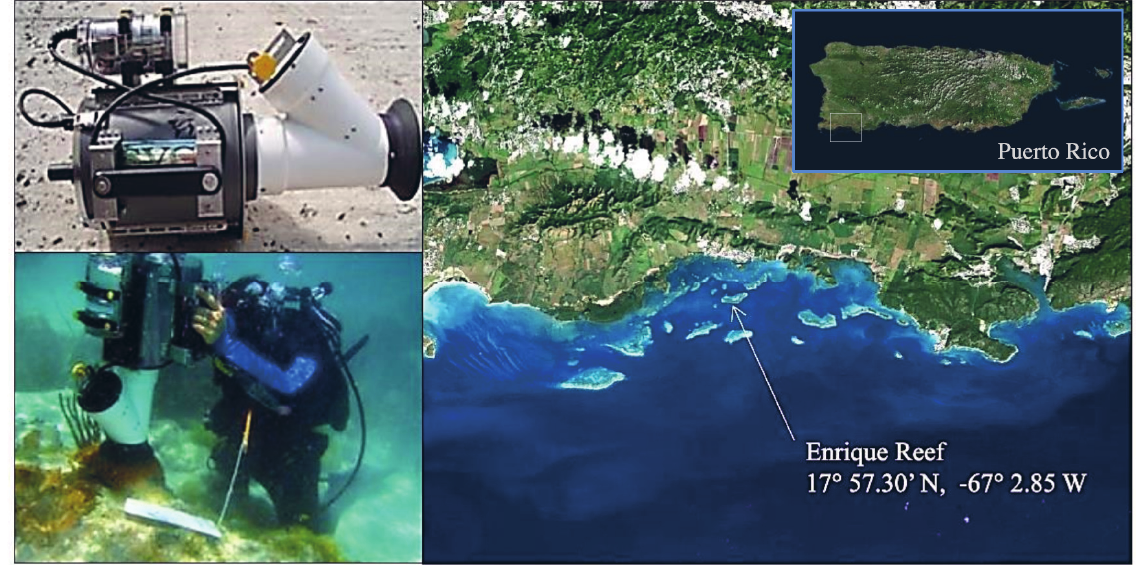
Figure 1. The GER-1500 spectrometer in underwater housing with attached illumination ( left ) and a map of the study location off the coast of southwestern Puerto Rico ( right